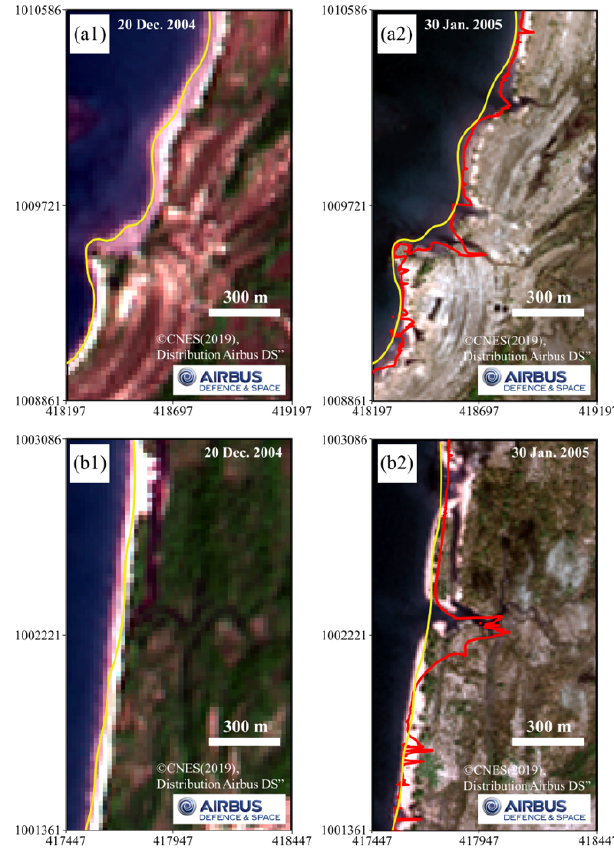
Figure 6. Comparison of observed shoreline position from Fig. 5 regions (a) and (b) derived from satellite images before and after the tsunami (20 December 2004 and 30 January 2005), which is overlain by the modeled extent of erosion showing that the modeled results closely match the observed changes. The red line is the cal- culated shoreline after the tsunami, and the yellow line is the shore- line before the tsunami (© CNES, 2019, Distribution Airbus DS”). (a1) Satellite image before the tsunami in region (a). (a2) Satellite image after the tsunami in region (a). (b1) Satellite image before the tsunami in region (b). (b2) Satellite image after the tsunami in region (b)